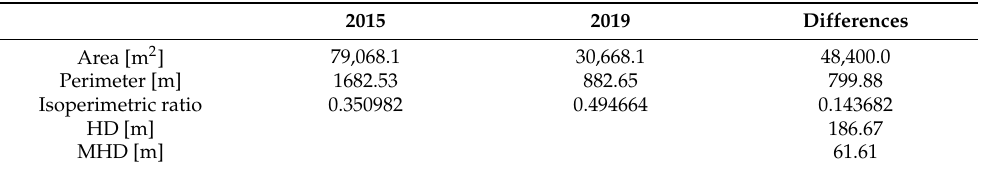
Table 4. Characteristics of the final segmentation curves from Figure 11 final segmented areas, showing their difference in area, perimeter, isoperimetric ratio and classical (HD) and mean (MHD) Hausdorff distances of two segmentation curves.